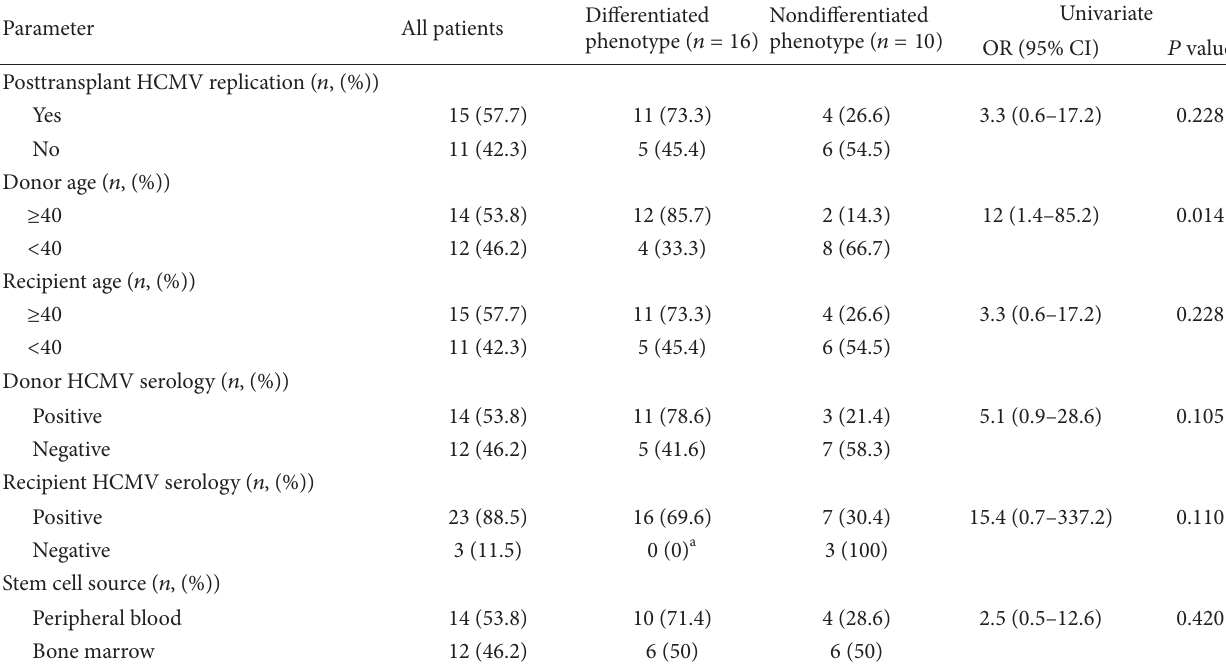
T 2: Univariate analysis of factors associated with “differentiated phenotype” in CD8+ HCMV-speci�c T cells. Parameter